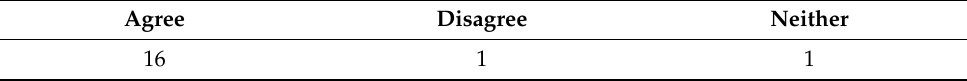
Table 12. Opinion on the Kunugiyama observation site as local landscape of the community. Agree Disagree